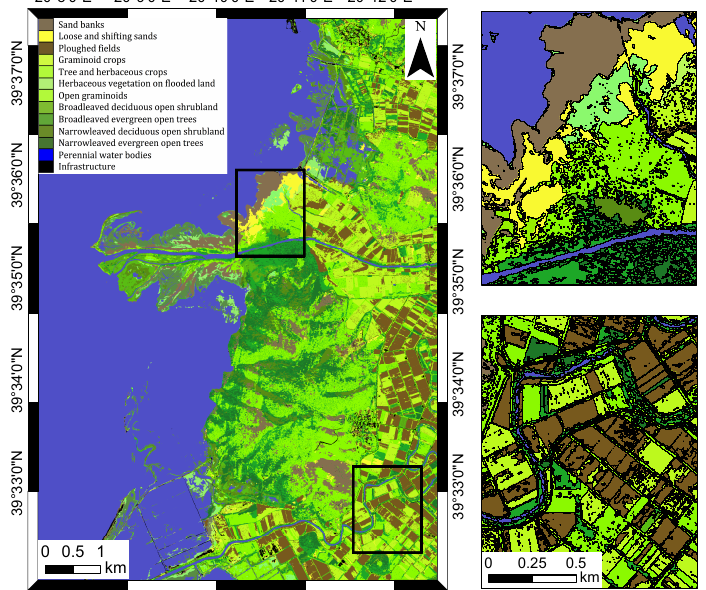
Figure 7. Classification of the Kalimas Delta, Greece, using the Earth Observation Dynamic Habitat Mapping (EODHaM) system. Subsets show the outlines of merged objects for each